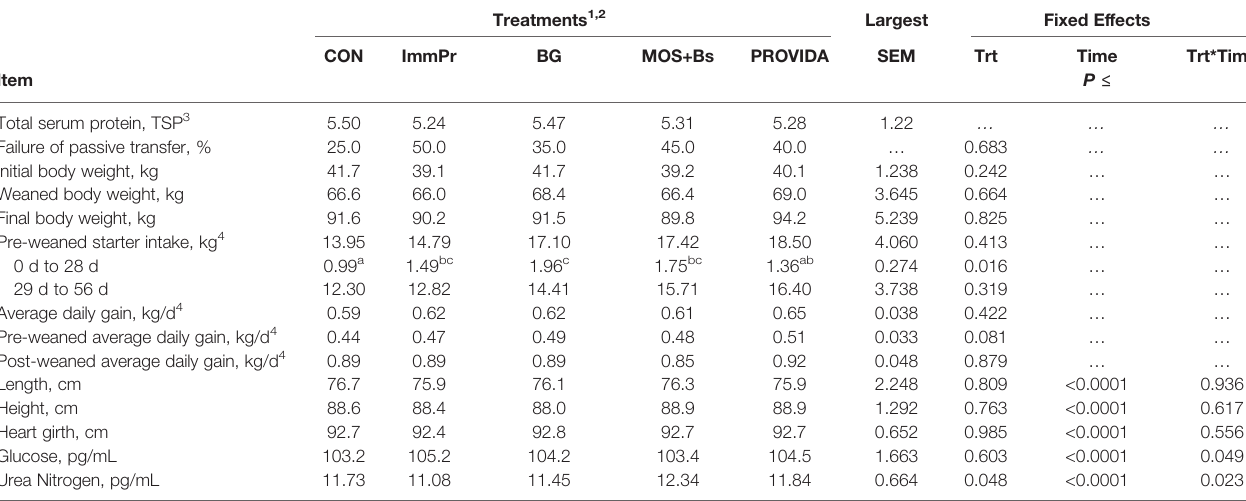
TABLE 3 | The effect of treatments on performance measurements in high-risk Holstein dairy calves.